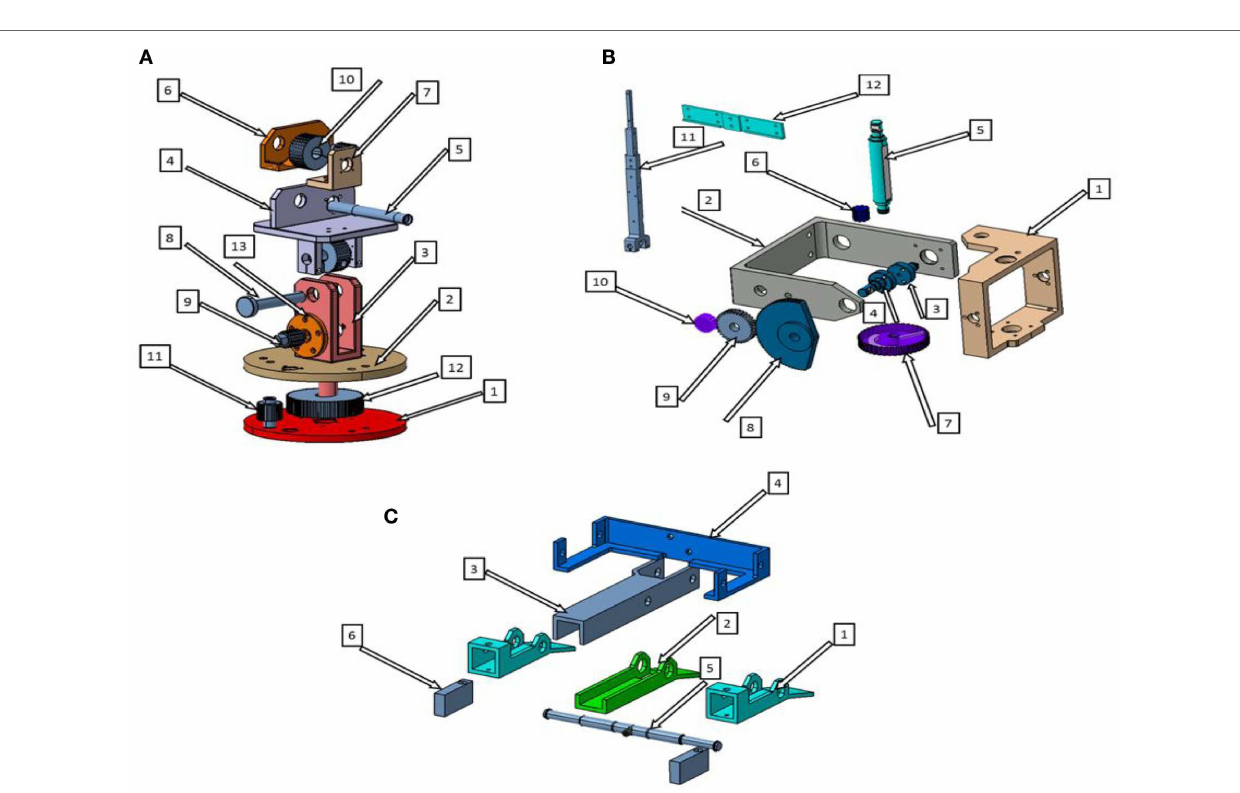
FIGURE 9 | Exploded view with numbering parts of HYDROïD’s head: (A) neck sub-system, (B) eye sub-system, and (C) mouth sub-system .